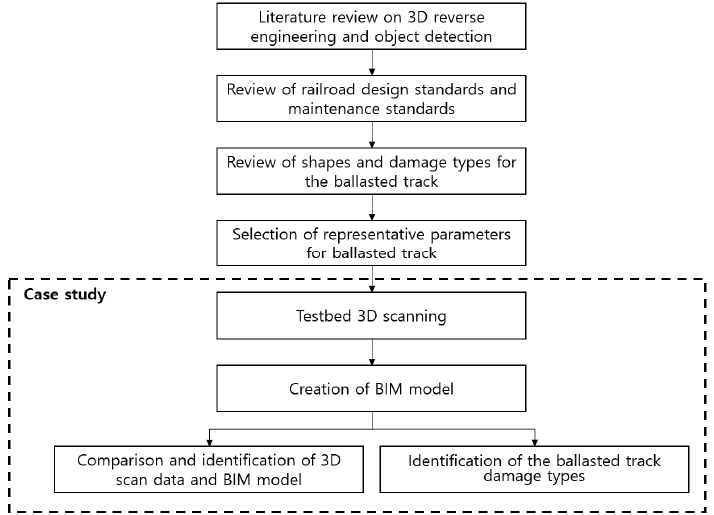
Figure 2. Research process .